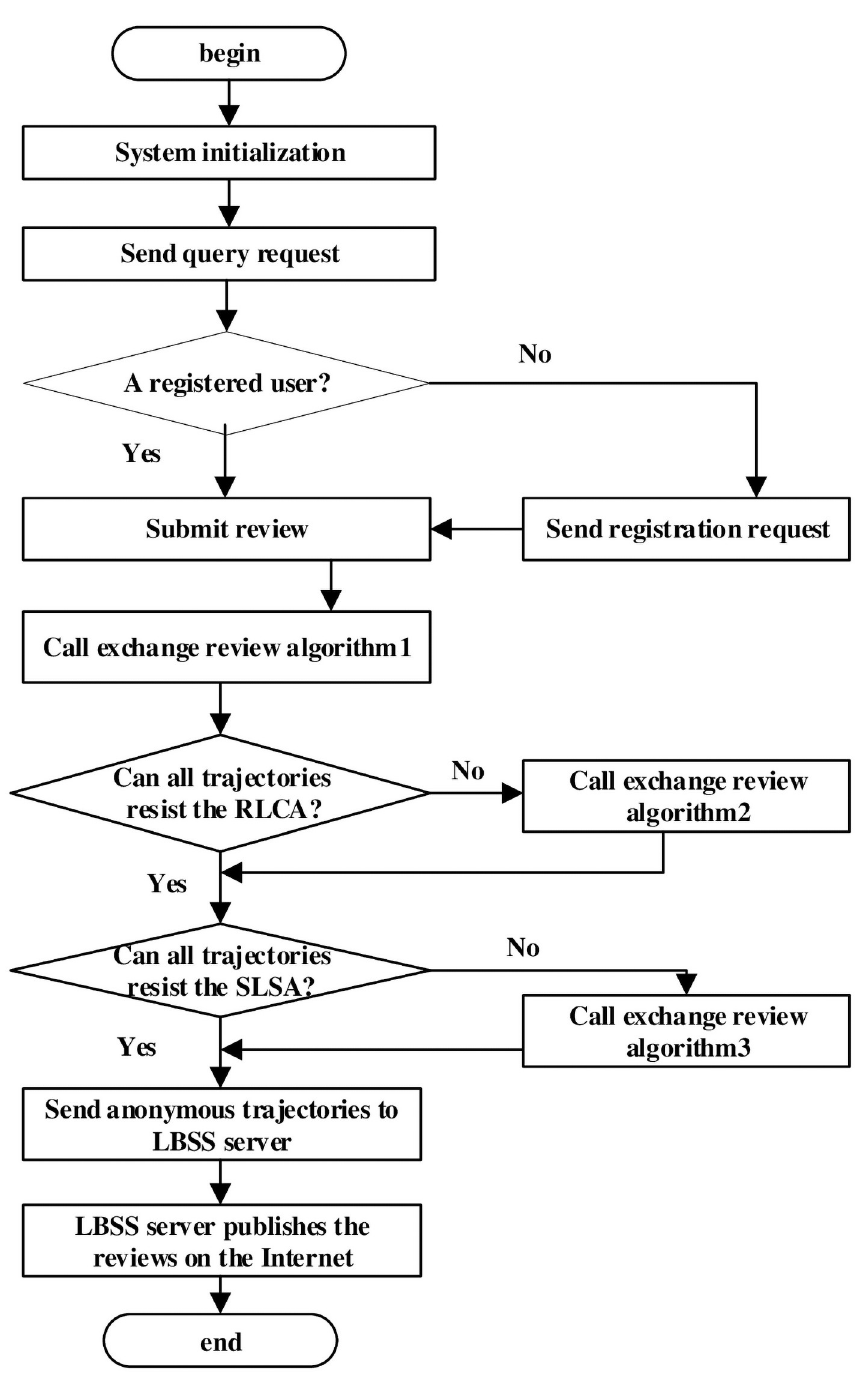
Fig 3. The framework of our